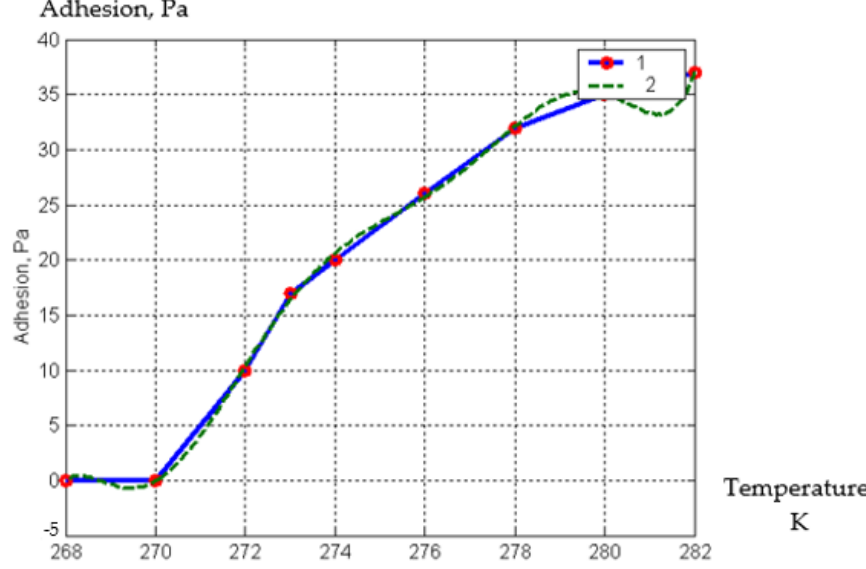
Figure 5. The dependence of the adhesion (Pa) of pieces of squash to each other on the temperature (K) on their surface; 1—experimental curve, 2—approximating curve.